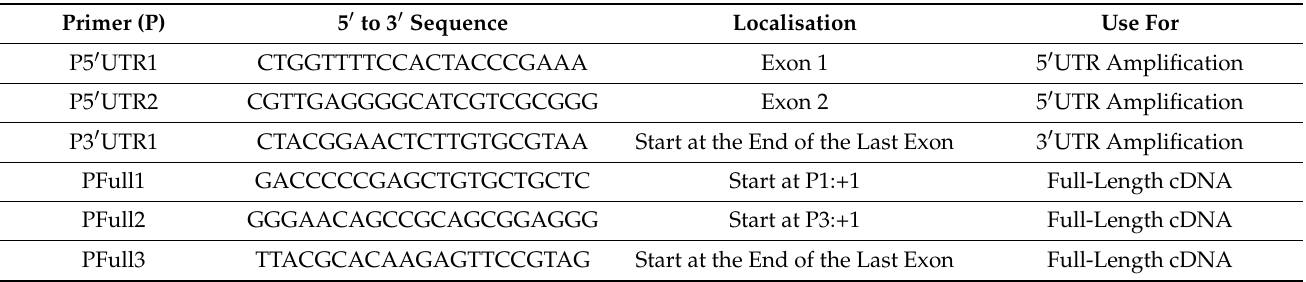
Table 1. Primers (P) that were used to obtain 5 (cid:48) UTR, 3 (cid:48) UTR and total length cDNAs of c-MYC transcripts or only open reading frames (ORFs) are indicated. The underlined sequences CATATG of Orf-c-MycS, present in all of-c-Myc, corresponds to NdeI restriction sites; the underlined sequence of Orfs corresponds to XhoI restriction site; CTG and ATG: Translation start codons; TTA: reverse complement Stop